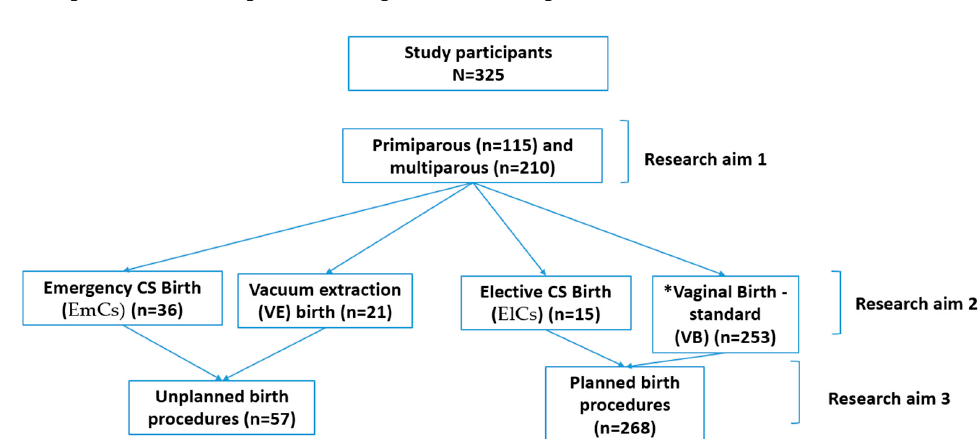
Figure 1. Participants and research aim flow diagram. Abbreviation: * the study used terminology of vaginal birth instead of standard vaginal of delivery.